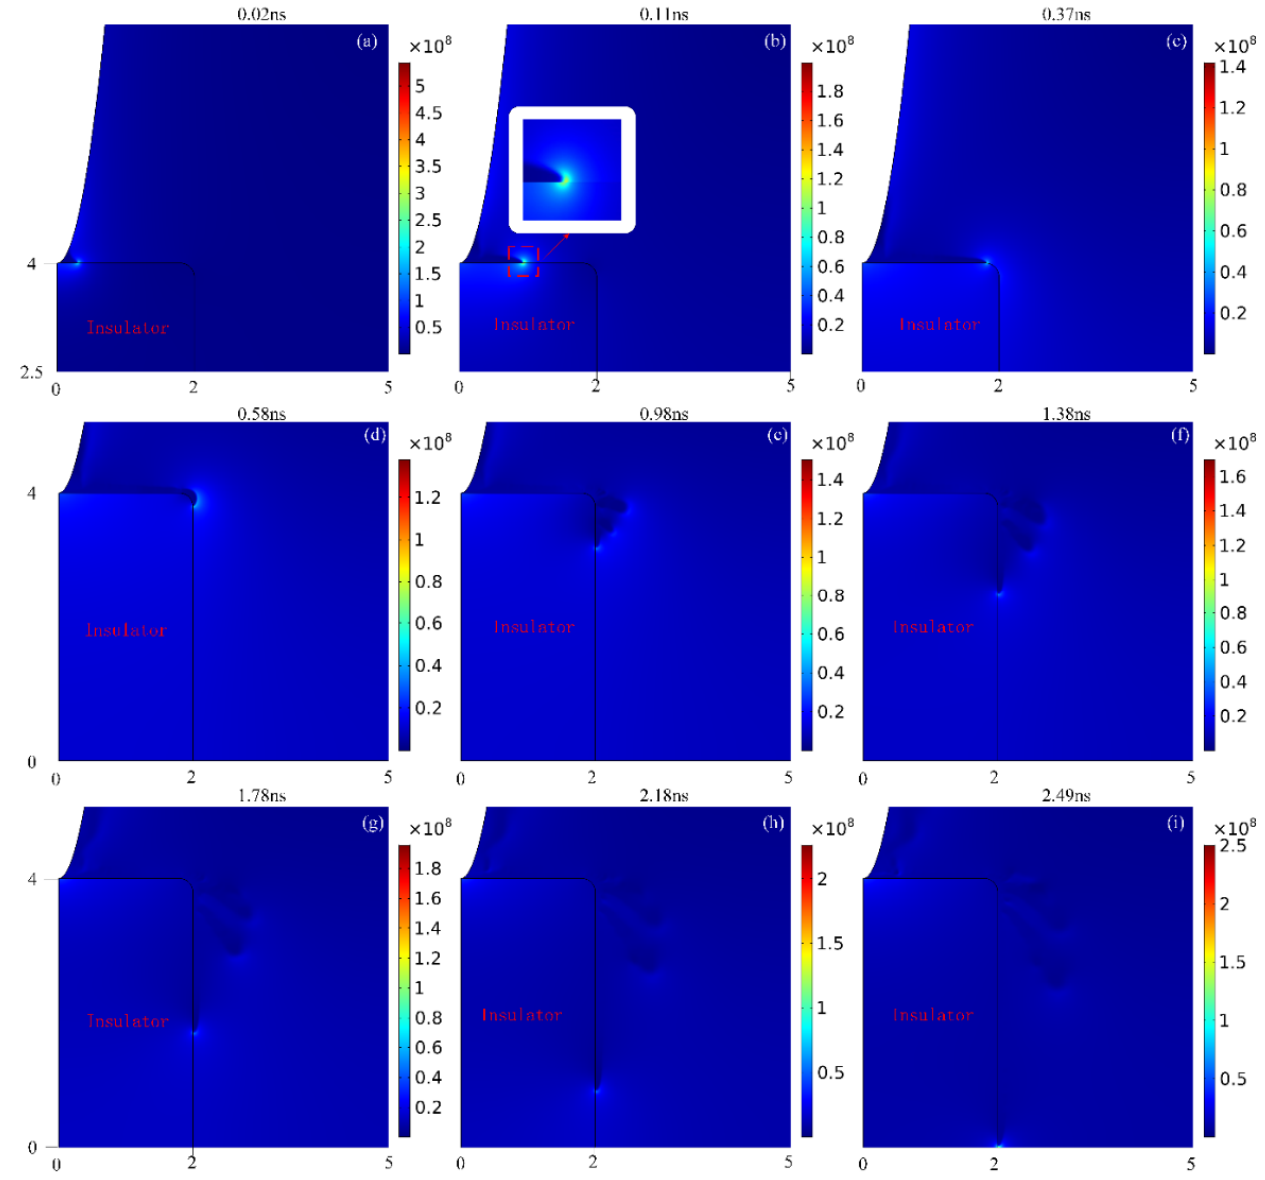
Figure 4. The distribution of the electric field (V/m), from 0.02 ns ( a ) to 2.47 ns ( i ); the scale unit is millimeters (mm). ( a – c ) development of streamer on upper surface of insulator; ( c , d ) streamer transitions from the top surface of the insulator to the right surface; ( d – i ) development of streamer on the right surface of insulator.